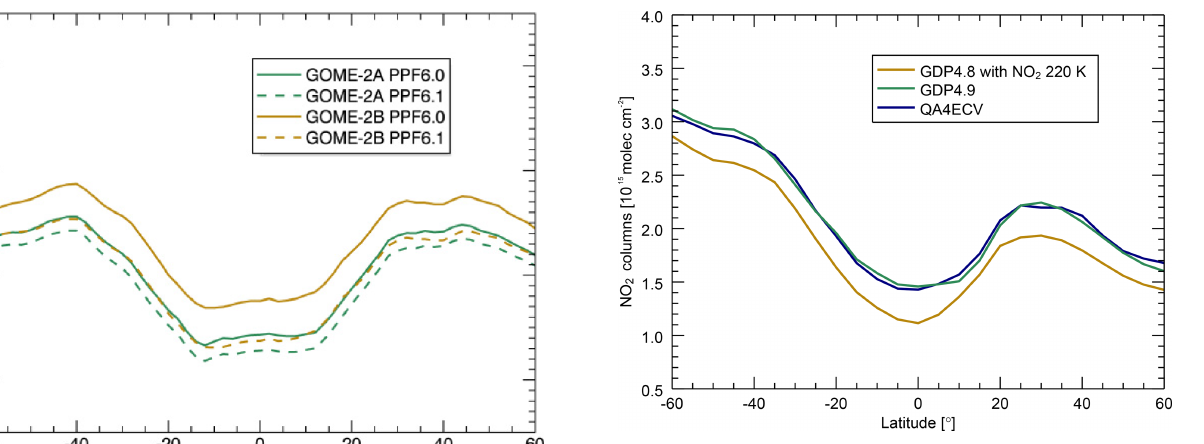
Figure 5. Comparisons of monthly zonal average NO 2 columns (slant columns scaled by geometric AMFs) from the operational GDP 4.8 product (but retrieved using a 220K NO 2 cross section from Vandaele et al., 2002) (brown), the improved GDP 4.9 al- gorithm (green), and the QA4ECV dataset (blue) over the Pacific (160–180 ◦ E) in February 2007 for